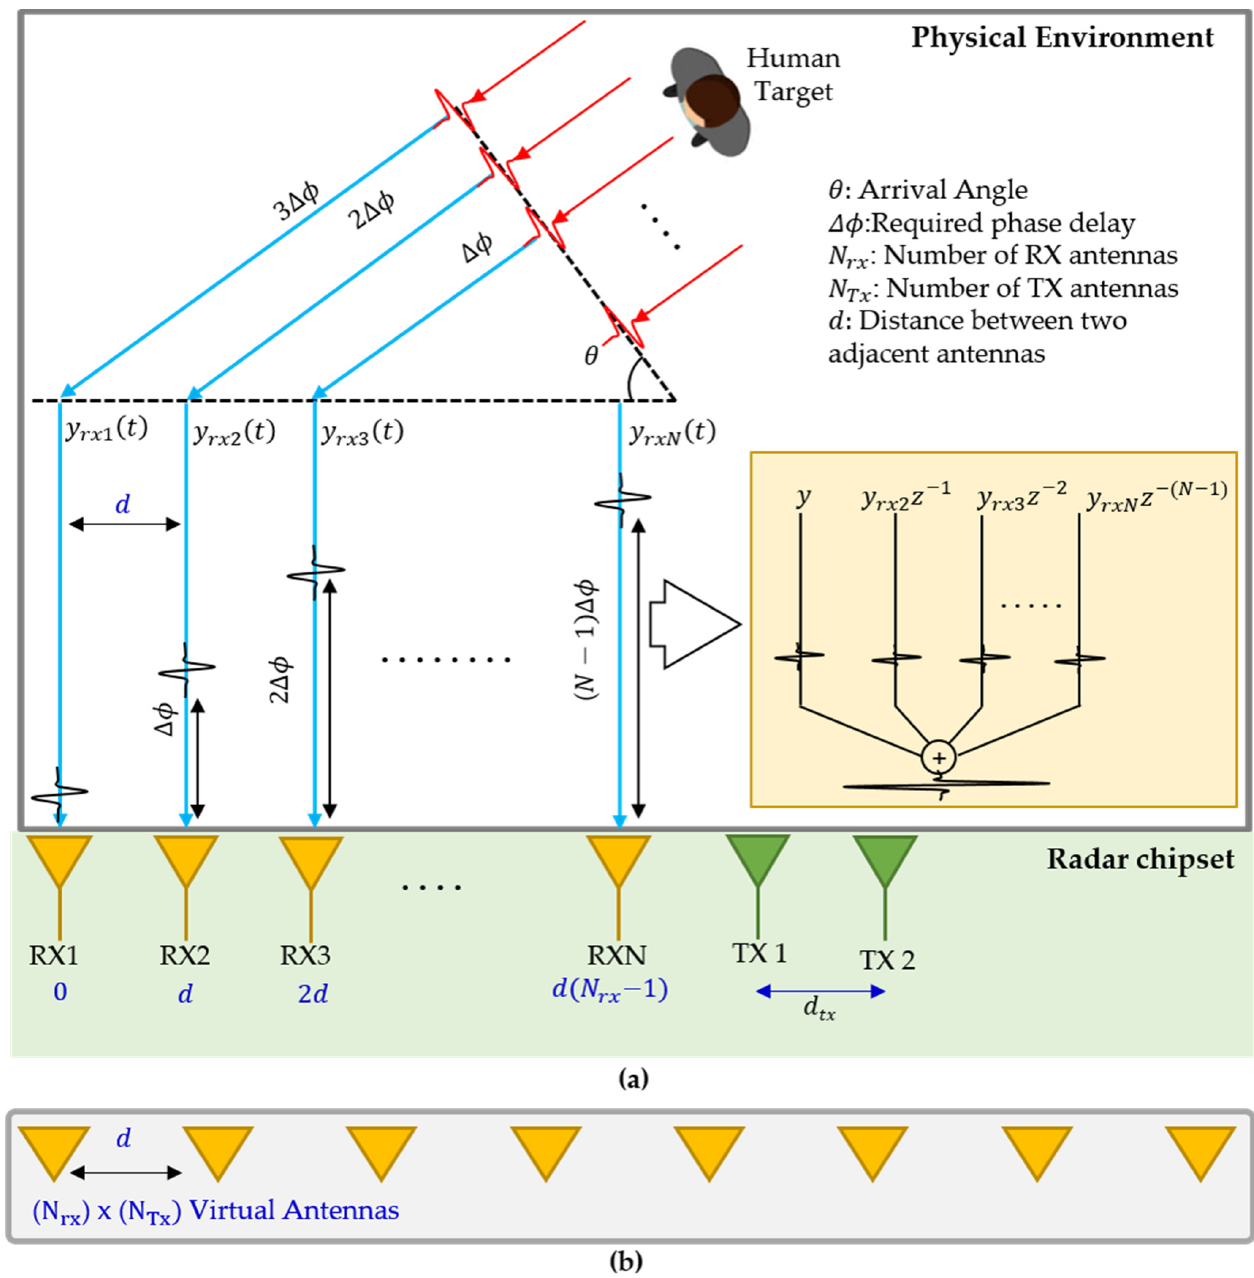
Figure 4. ( a ) MIMO system in consideration for vital sign extraction and ( b ) the virtual MIMO array.